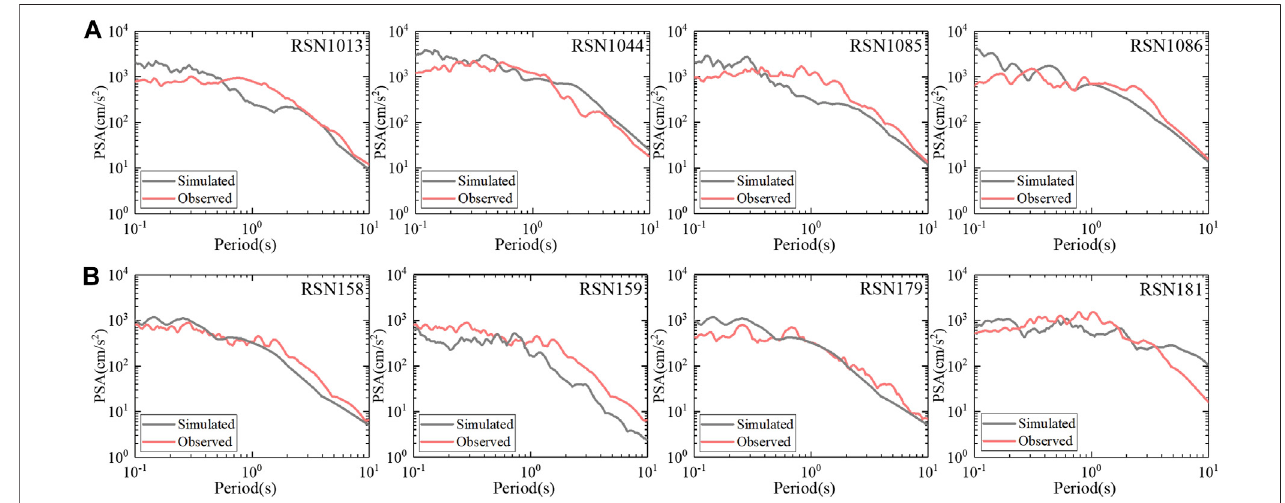
FIGURE 3 | The simulated and observed response spectra produced by bedrock ground motion from (A) the Northridge Earthquake and (B) the Imperial Valley Earthquake.